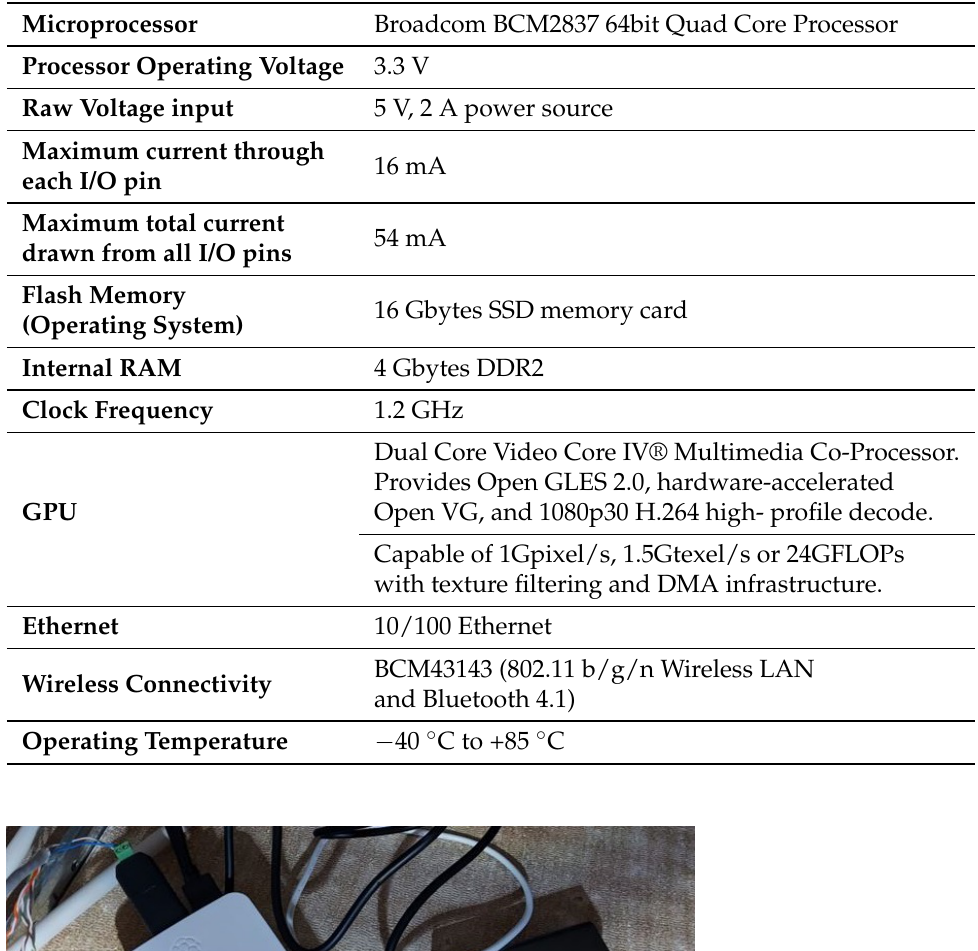
Table 7. Raspberry Pi 3 technical specifications.